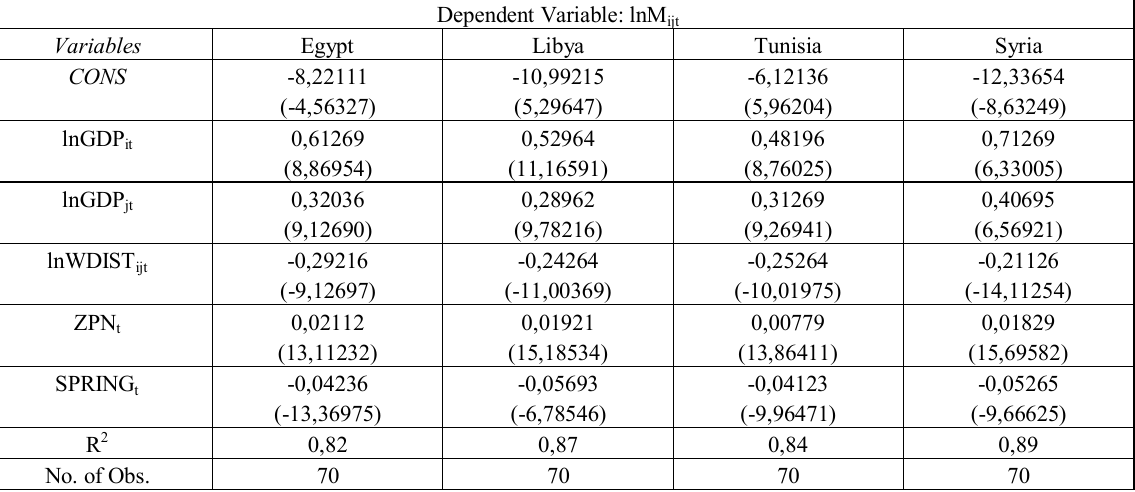
Table 2B: Estimation Results for Import